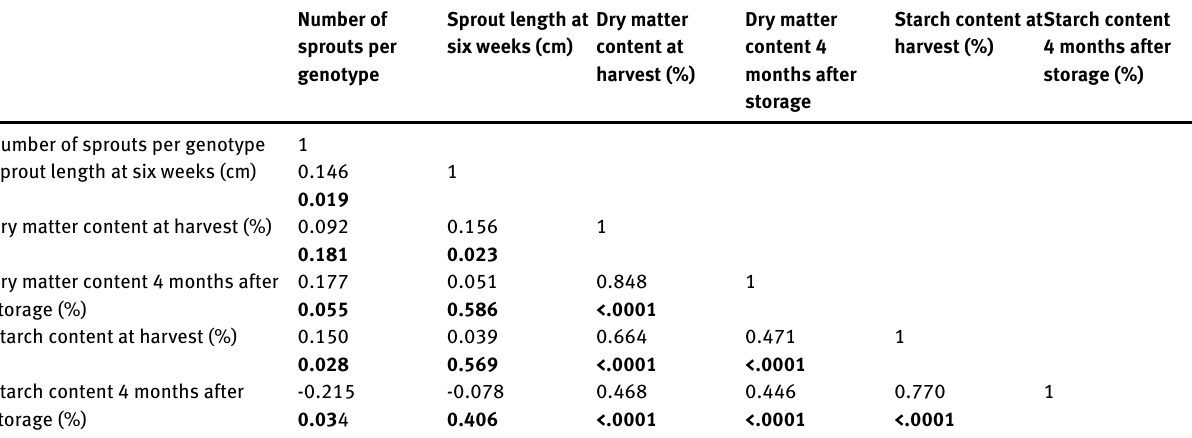
Table 7: Pearson Correlation Coefficients among the field and quality traits measured at Umbeluzi Research Station and Nwalate Farm